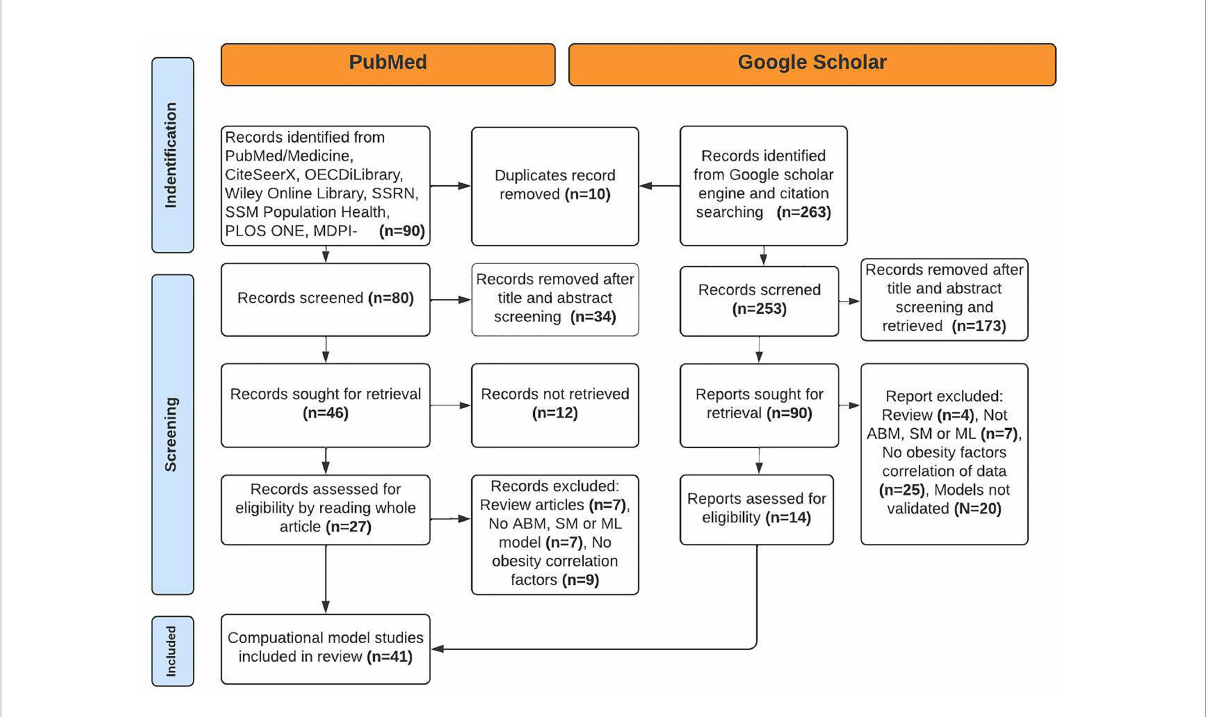
FIGURE 1 PRISMA diagram of identi fi cation and selection of studies for the